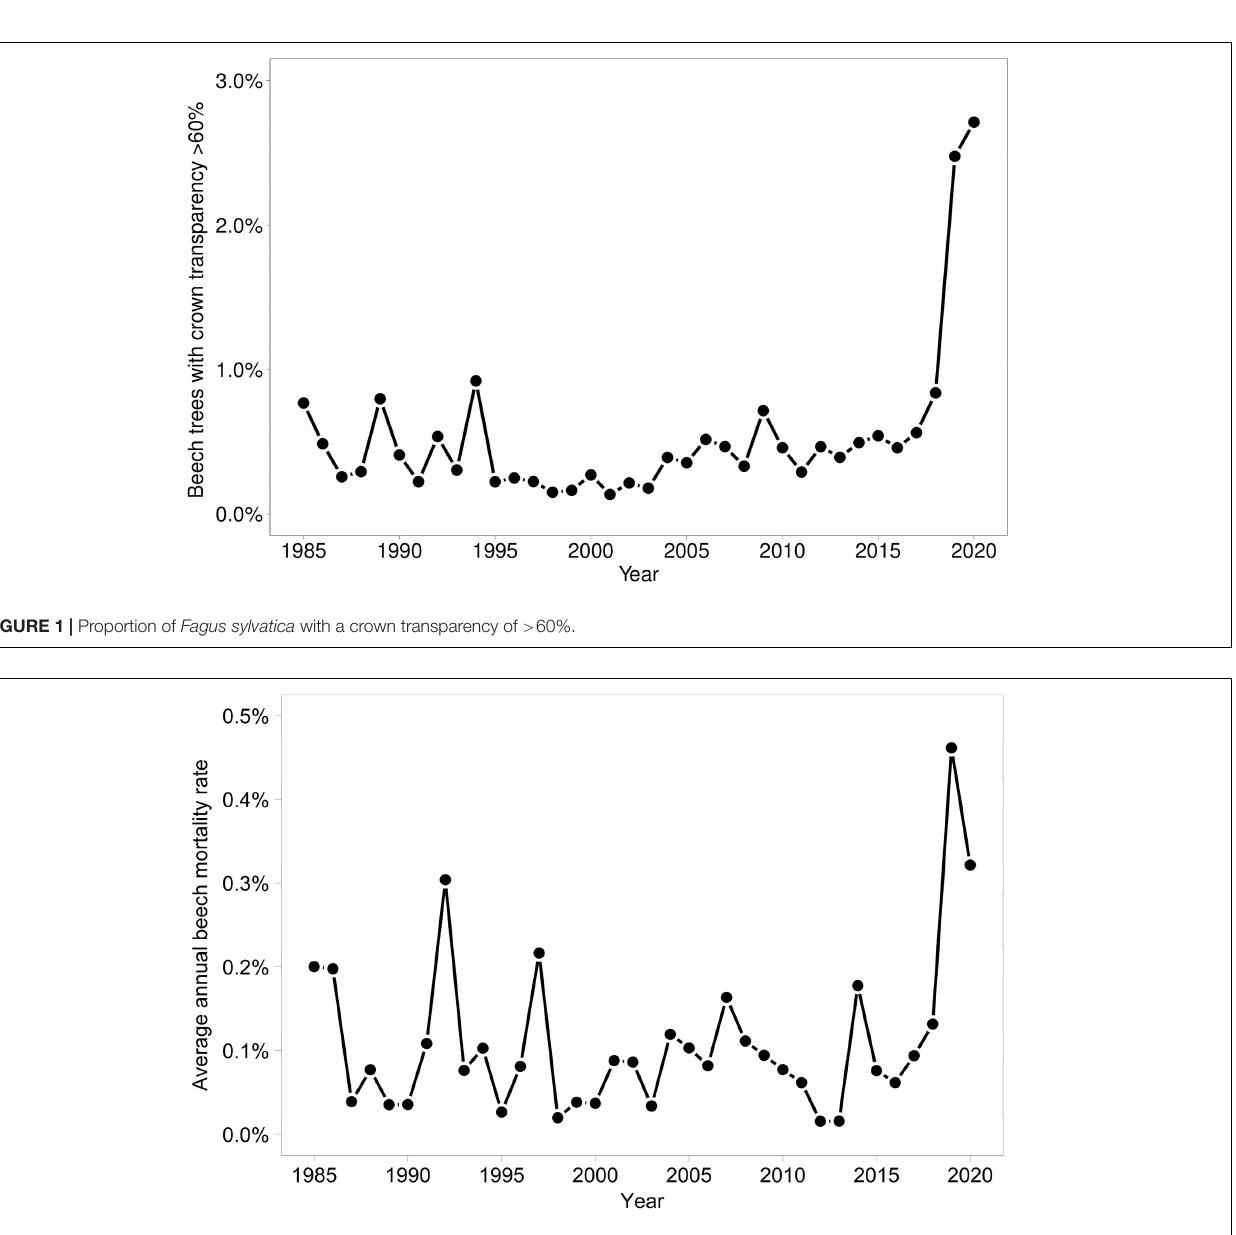
FIGURE 2 | Annual average mortality rates of Fagus sylvatica